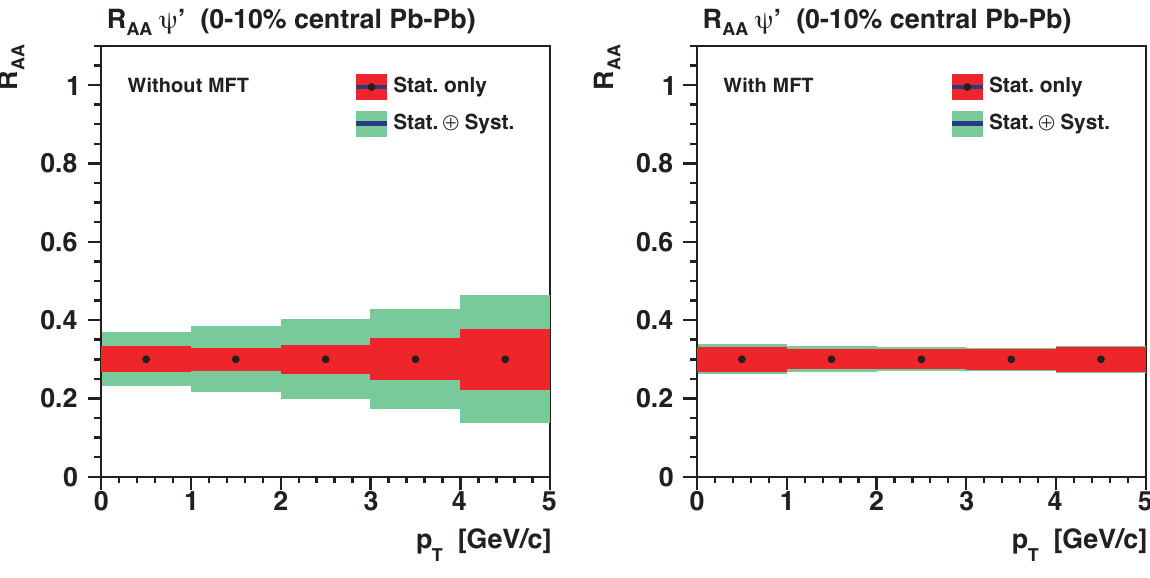
Figure 5. Expected statistical and systematical uncertainties of the nuclear modification factor R AA of the ψ (cid:48) in central Pb-Pb collisions without MFT (left panel) and with MFT (right